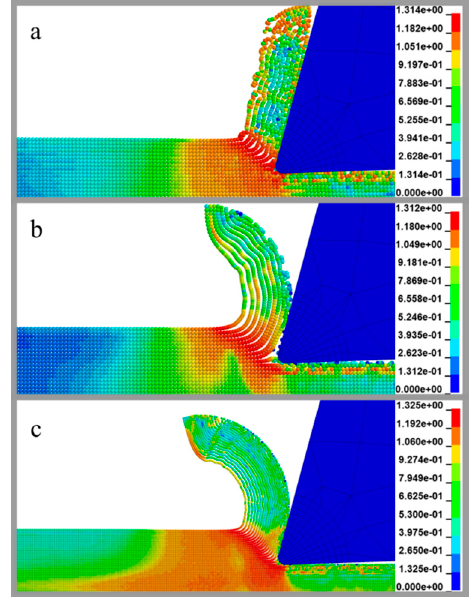
Figure 4. Equivalent stress σ eq contours in GPa for 0.06 mm depth of cut: ( a ) standard formulation and d = 0.01 mm; ( b ) renormalized formulation and d = 0.01 mm; ( c ) renormalized formulation and d = 0.005 mm.